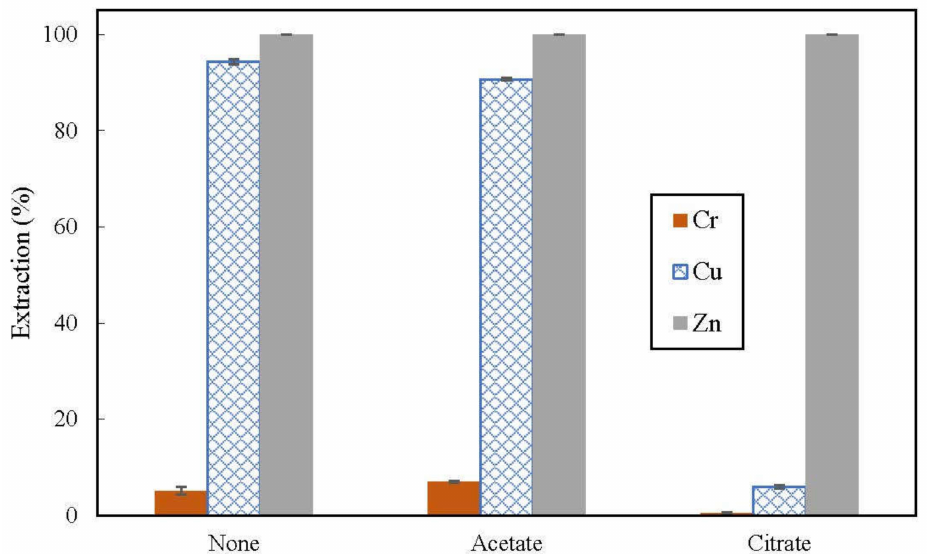
Figure 4. Effect of buffer on extraction of metal ions from feed containing 100 ppm chromium (VI), copper and zinc; organic phase consisted of 3% ( v / v ) D2EHPA in kerosene, pH eq = 3.60 ( ± 0.02), extraction time = 5